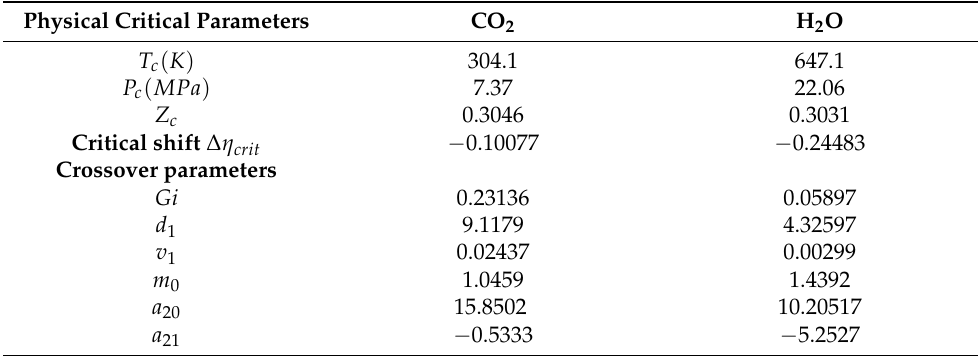
Table 1. System-dependent parameters for the crossover PR EoS